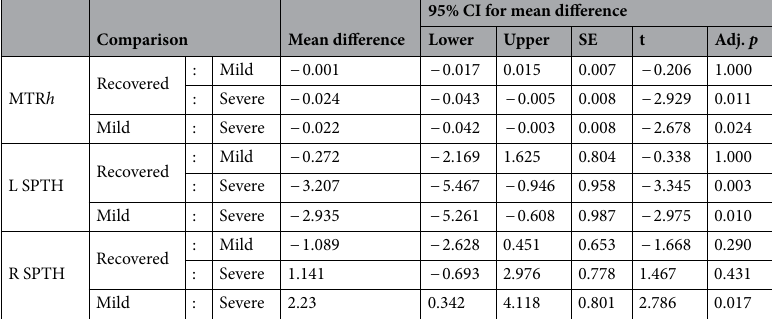
Table 3. Post-hoc comparisons with Bonferroni adjusted p values of magnetization transfer ratio (MTR) from white matter tracts and MTR homogeneity (MTR h ) between clinical outcome groups. White matter tracts above are the left and right combined spinothalamic and spinoreticular tracts (L and R SPTH).